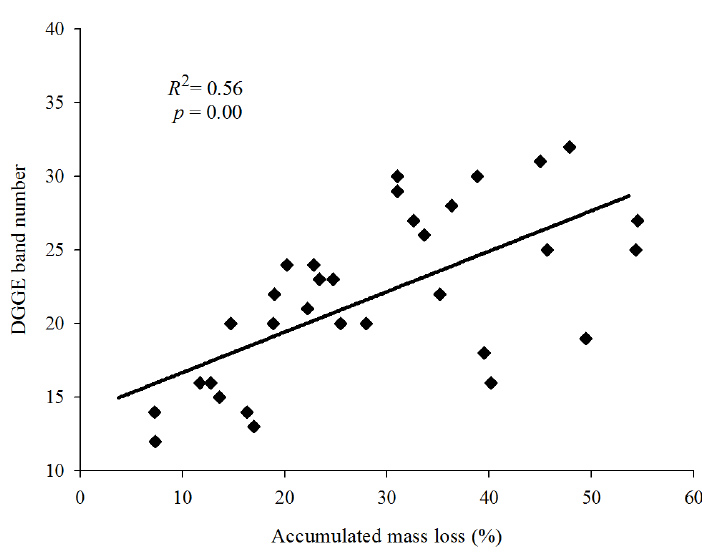
Figure 2. Linear relationships between the accumulated mass loss and the fungal DGGE band numbers. Table 4. Shannon-Wiener index ( H ), the richness of the DGGE bands ( S ) and mass loss ( M ) (%) during the decomposition of the eight litter treatments.